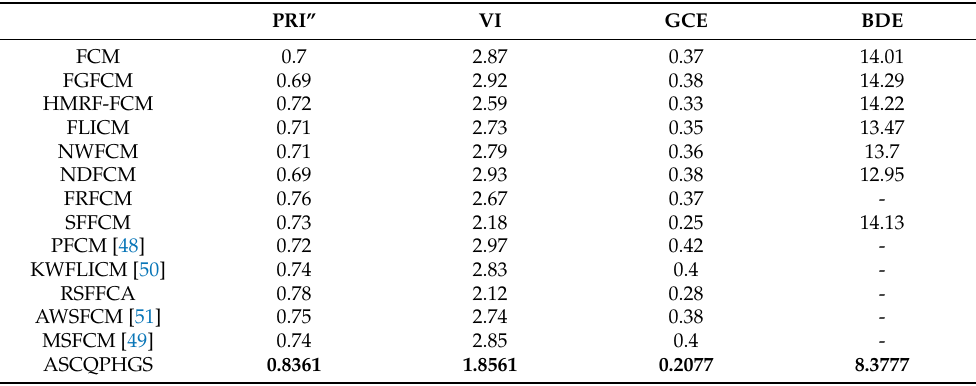
Table 4. Comparison with other literature